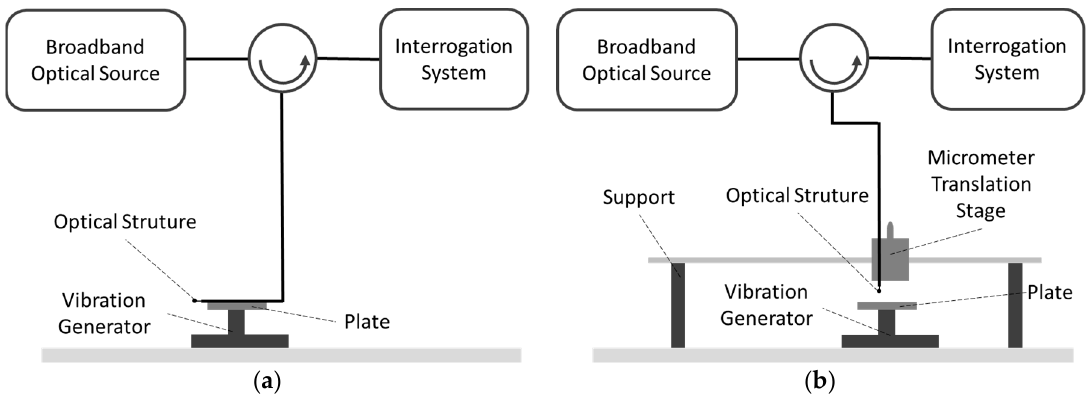
Figure 4. Assembly diagram for vibration with the sensor positioned: ( a ) Parallel and ( b ) perpendicular.